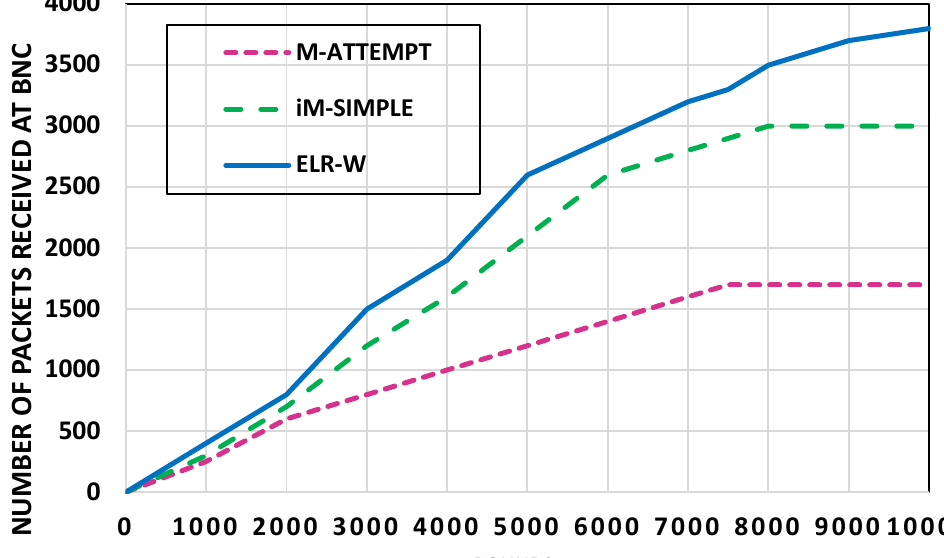
Figure 6. Analysis of network throughput.